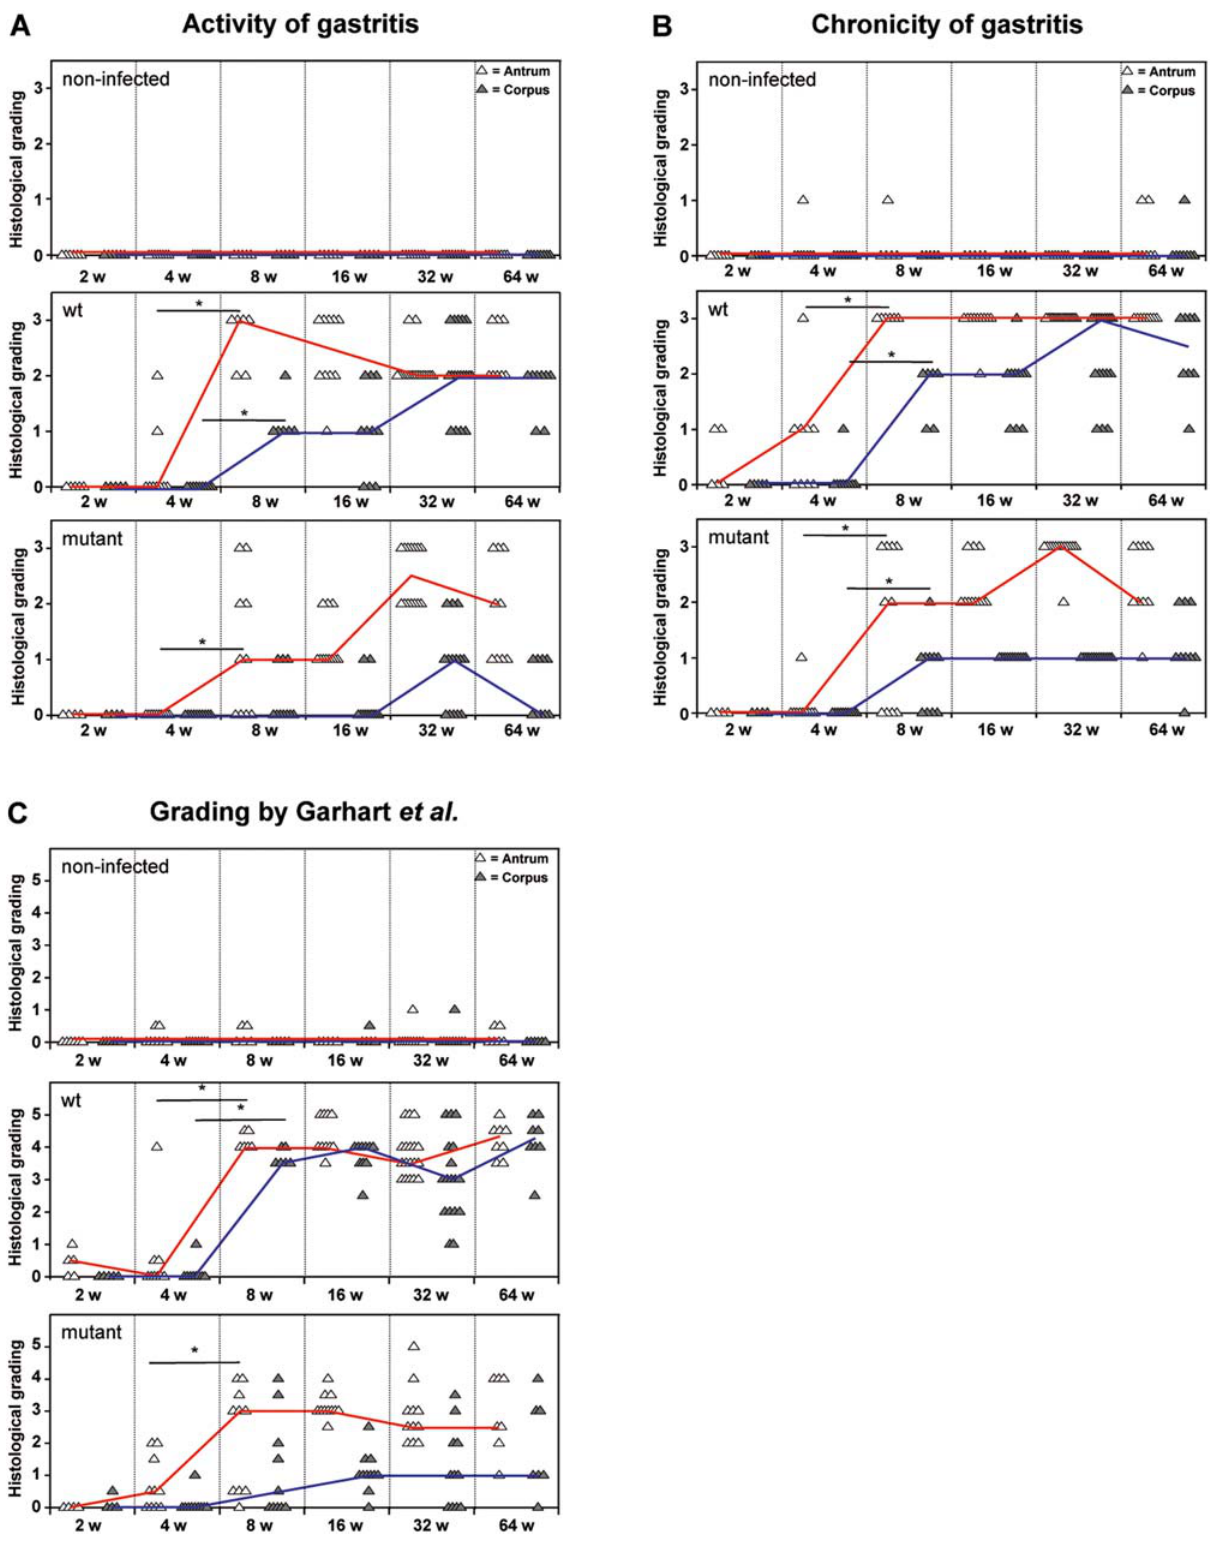
Figure 2. Induction of corpus dominant gastritis is B128 WT dependent. Histological grading of antral (white triangles) and corpus (gray triangles) mucosa. Gerbils were orally challenged with H. pylori B128 WT (middle panels) and B128 D cag Y (bottom panels) isogenic mutant strain for 2, 4, 8, 16, 32, and 64 weeks compared with age-matched non-infected controls (upper panels). (A) Active gastritis and (B) chronic gastritis grading was performed according to the upgraded Sydney system, and (C) according to Garhart et al . The interpolated lines connect the medians of the respective time-points. (*p , 0.05). doi:10.1371/journal.pone.0004754.g002 PLoS ONE |